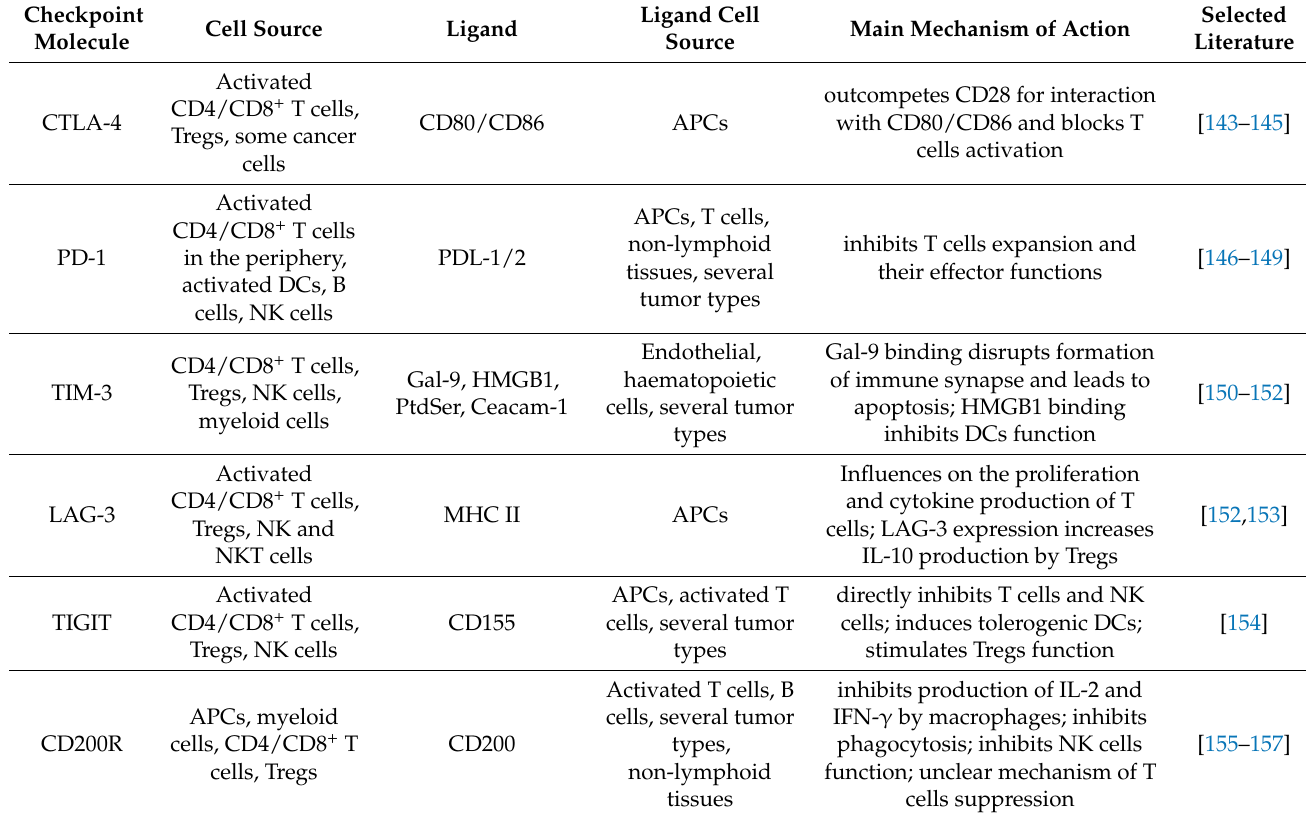
Table 4. Overview of the inhibitory immune checkpoint